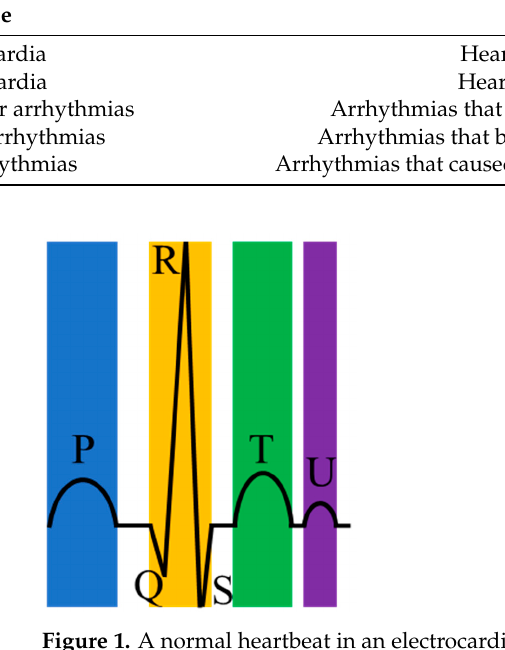
Figure 1. A normal heartbeat in an electrocardiogram (ECG). Table 2. The cause of generating each wave in ECG.